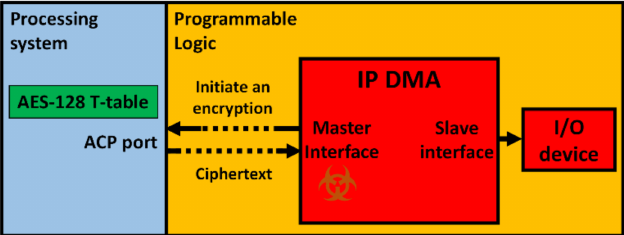
Figure 9. Threat model used for the Flush+Reload and the Evict+Time attacks.